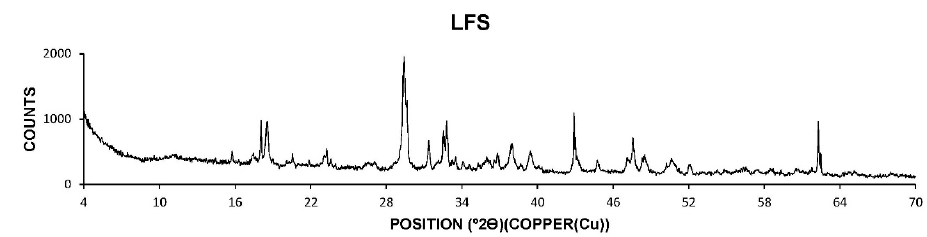
Figure 3. Results of X ‐ ray diffraction of ladle furnace slag.